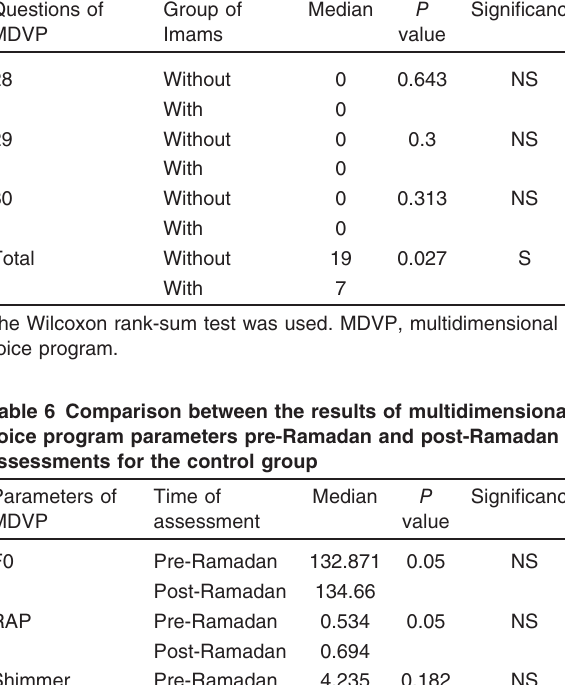
Table 8 Comparison between the results of pre-Ramadan and post-Ramadan assessments for VHI parameters in the